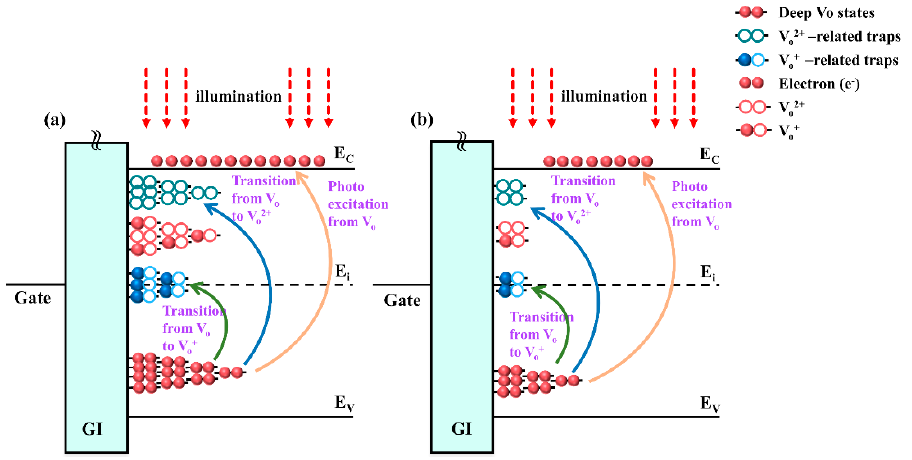
Figure 8. Schematic of the generation process of V o -related defect states under short-wavelength light illumination: ( a ) undoping, ( b ) 20% N-doping ratio.